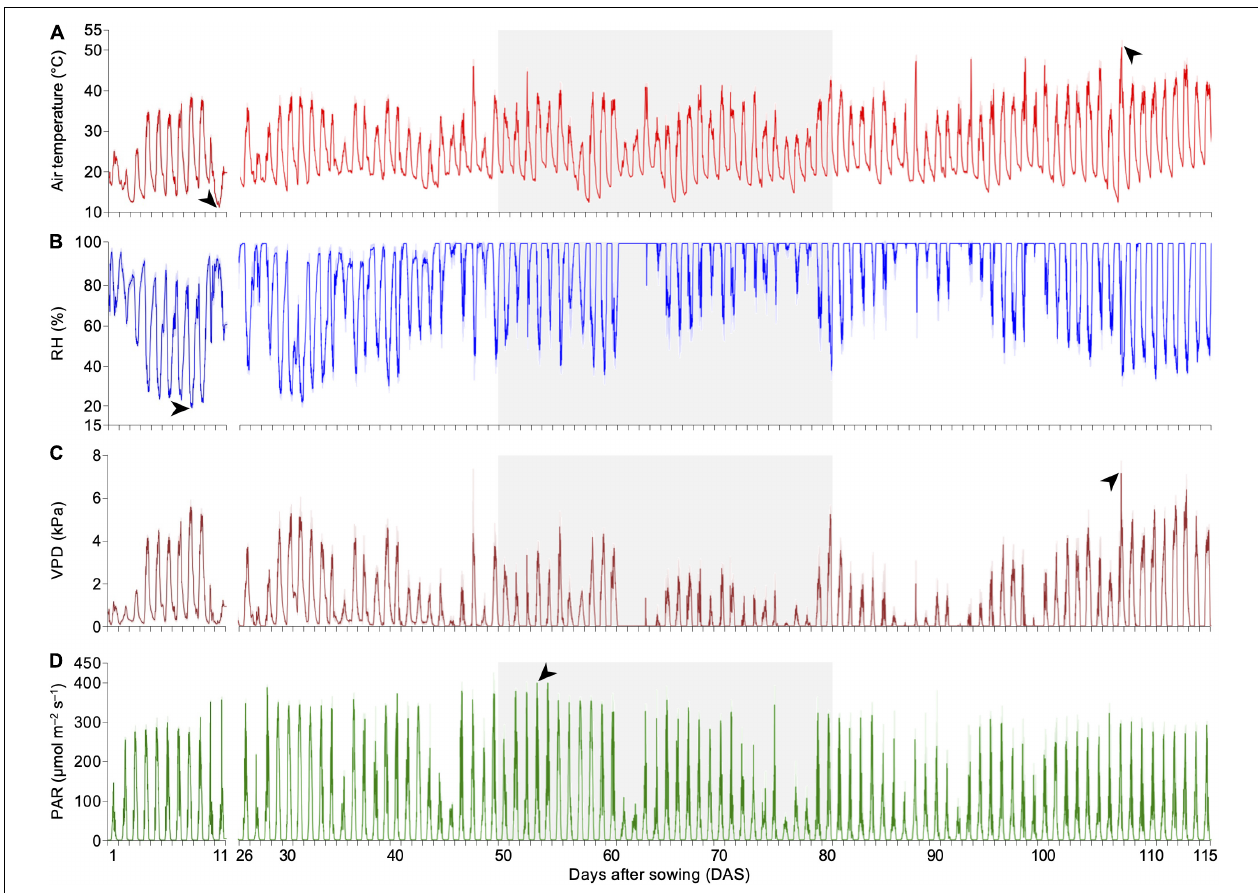
FIGURE 3 | Fluctuation of environmental parameters detected by the non-invasive real-time phenotyping platform. (A) Air temperature, with minimum and maximum observed at 11 DAS at 5:30 am (11.35 ± 0.05 ◦ C) and 107 DAS at 2:00 pm (51.38 ± 1.93 ◦ C), respectively (black arrows). (B) RH, with a minimum of 18.85 ± 0.15% at 8 DAS at 4:30 pm (black arrow). (C) VPD, found to reach a peak of 7.17 ± 0.60 kPa at 107 DAS at 2:15 pm (black arrow), following the high air temperature variation at that moment. (D) PAR, with a maximum peak of 400.53 ± 1.94 µ mol m − 2 s − 1 observed at 53 DAS at 12:00 pm (black arrow). Gray background highlights period of DS treatment. Data points were missing from 12 to 25 DAS due to an unexpected disruption of the automated measuring routine. DAS, days after sowing; RH, air relative humidity; VPD, vapor-pressure deficit; PAR, photosynthetically active radiation; DS, drought